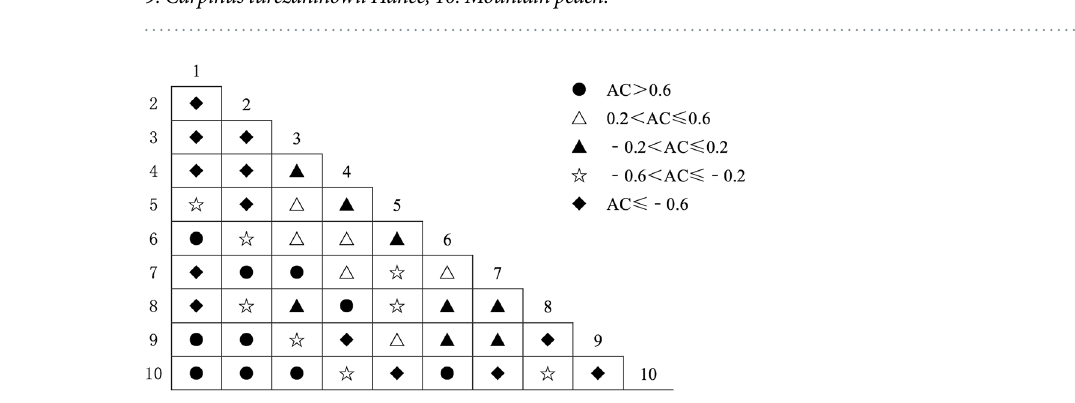
Figure 3. Half-matrix-diagram (AC Value) of interspecific association in Community I. Note: 1: Pinus tabulaeformis, 2: Quercus wutaishansea, 3: Betula platyphylla, 4: Populus davidiana, 5: Swida